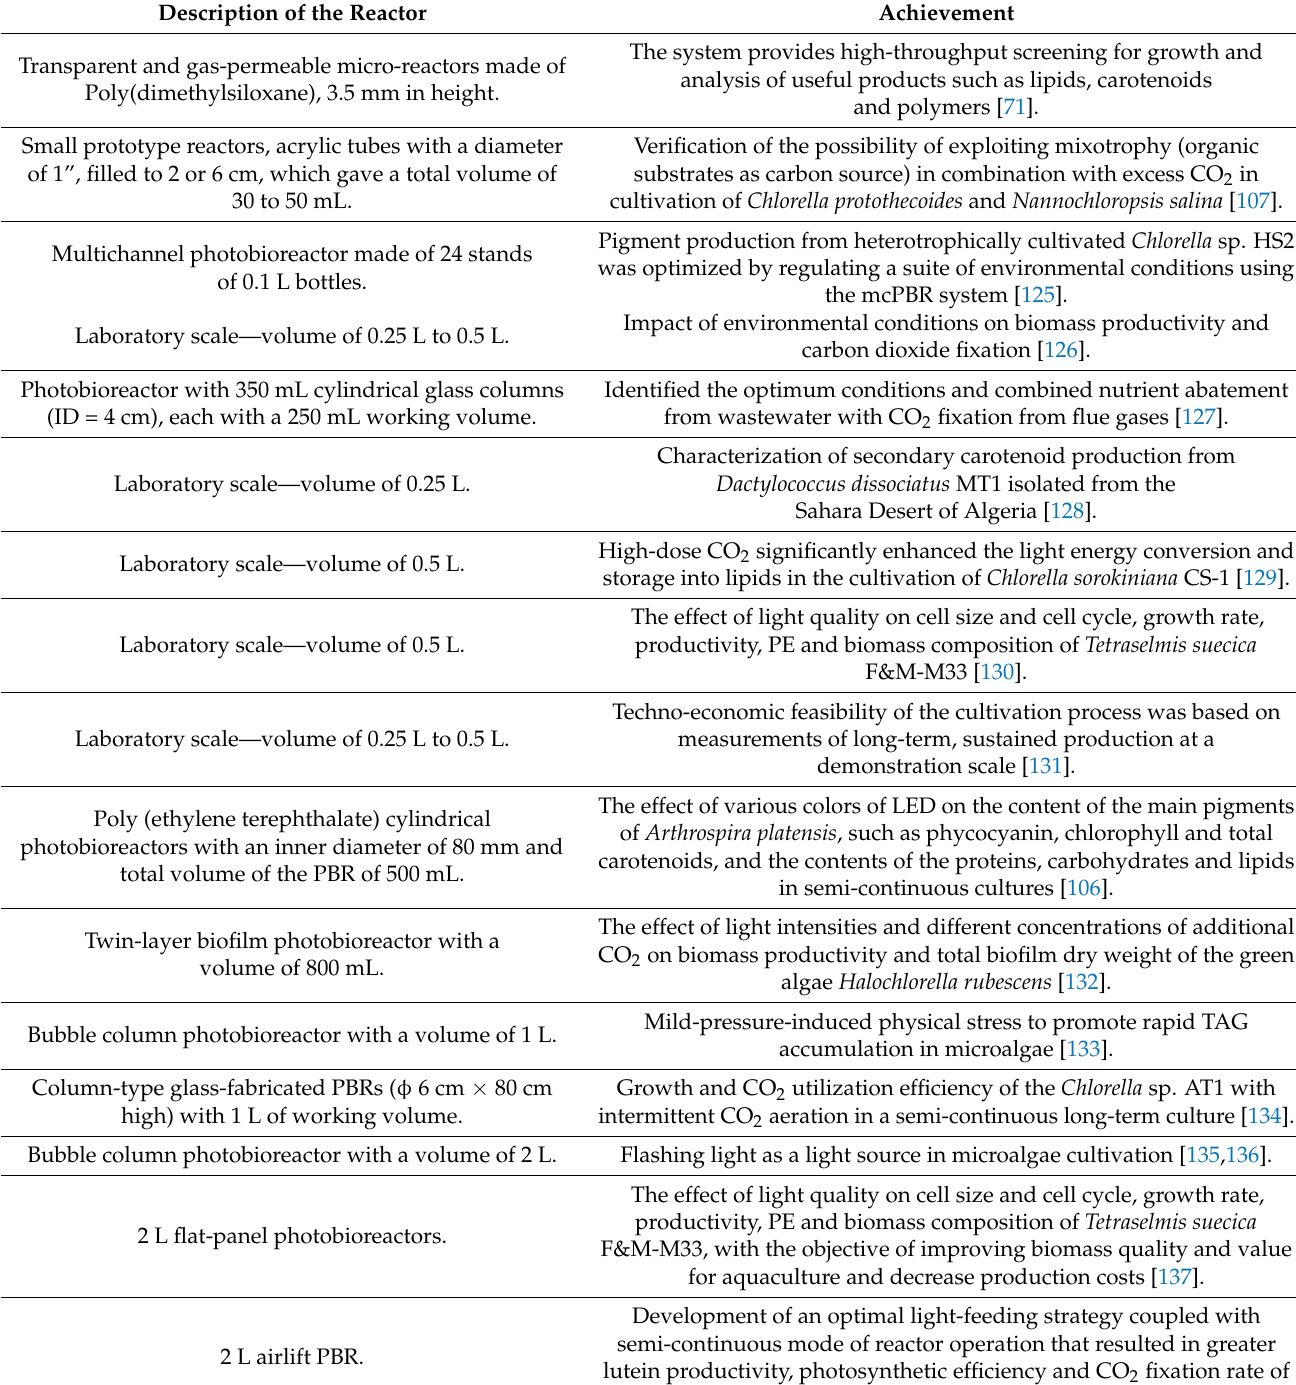
Table 10. Typical photobioreactor designs for biomass production of